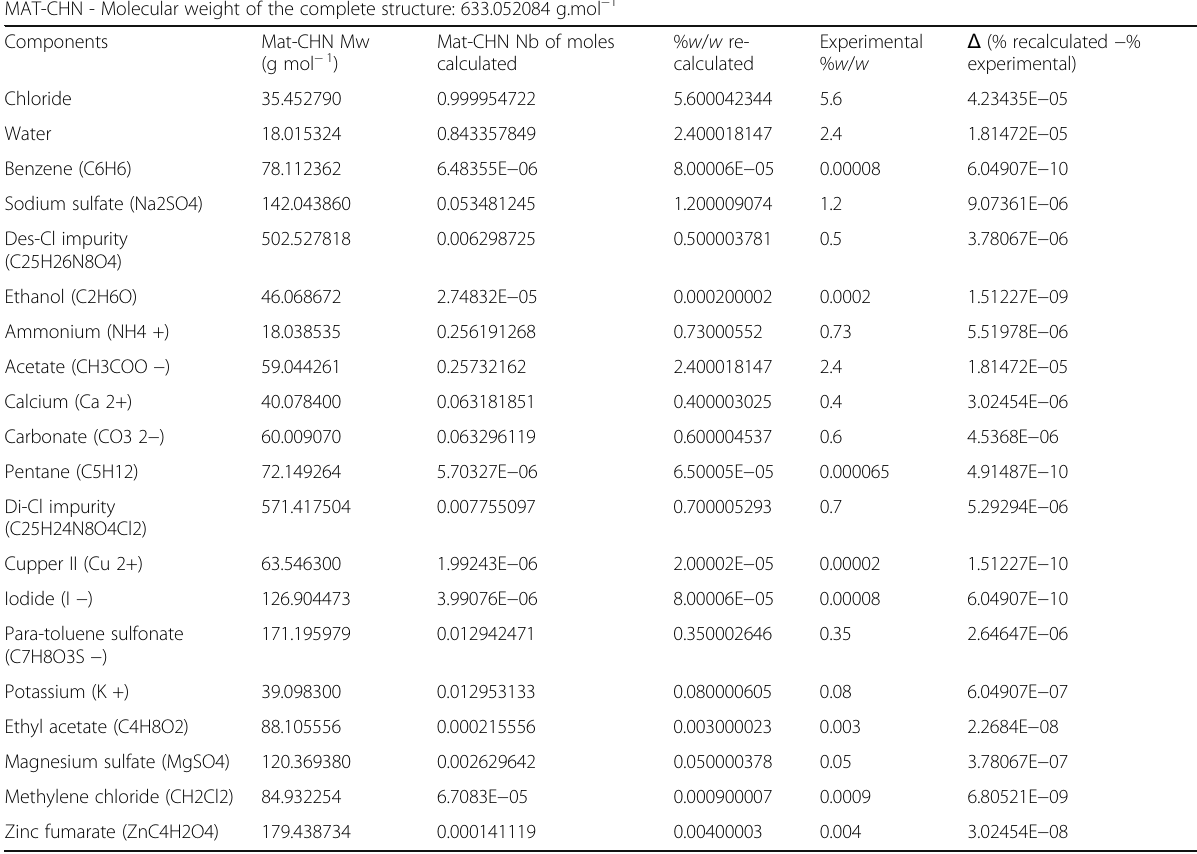
Table 2 Comparison of experimental and Mat-CHN recalculated % w / w of each component MAT-CHN - Molecular weight of the complete structure: 633.052084 g.mol − 1